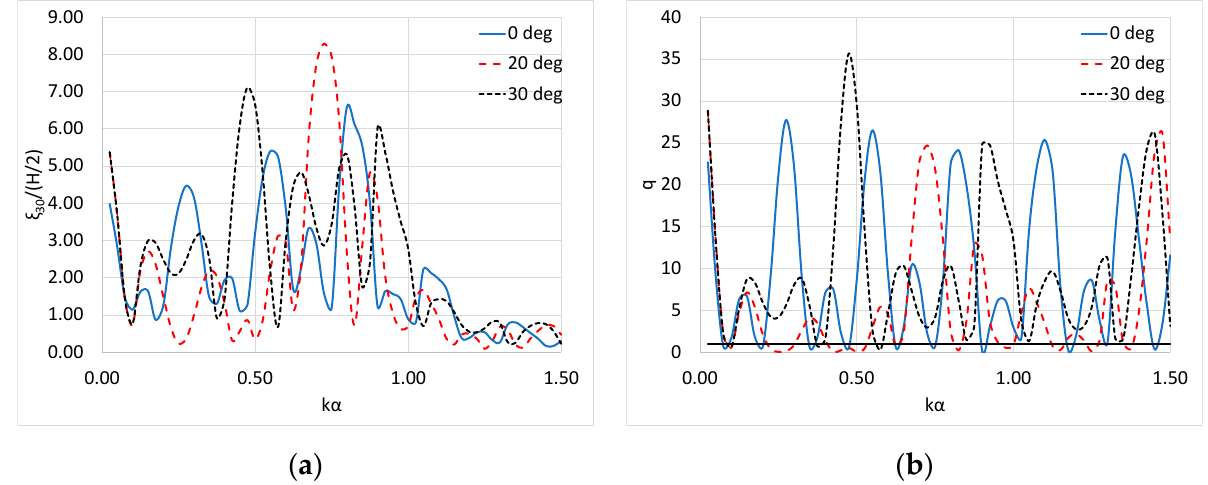
Figure 6. Effect of the V-shaped breakwater on the WEC’s (wave energy converter) performance for various examined wave heading angles β : ( a ) WEC’s (wave energy converter motions) heave; ( b ) q factor term. The horizontal solid line corresponds to unity.